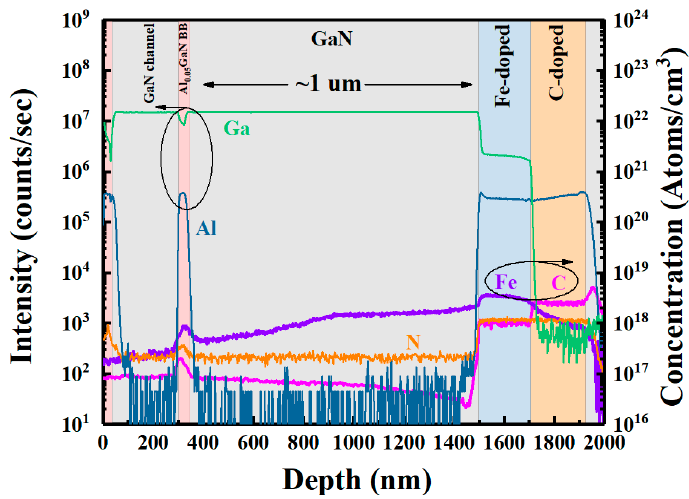
Figure 2. Secondary ion mass spectrometer (SIMS) measurement of AlGaN HEMT with BB/Fe- doped/C-doped.